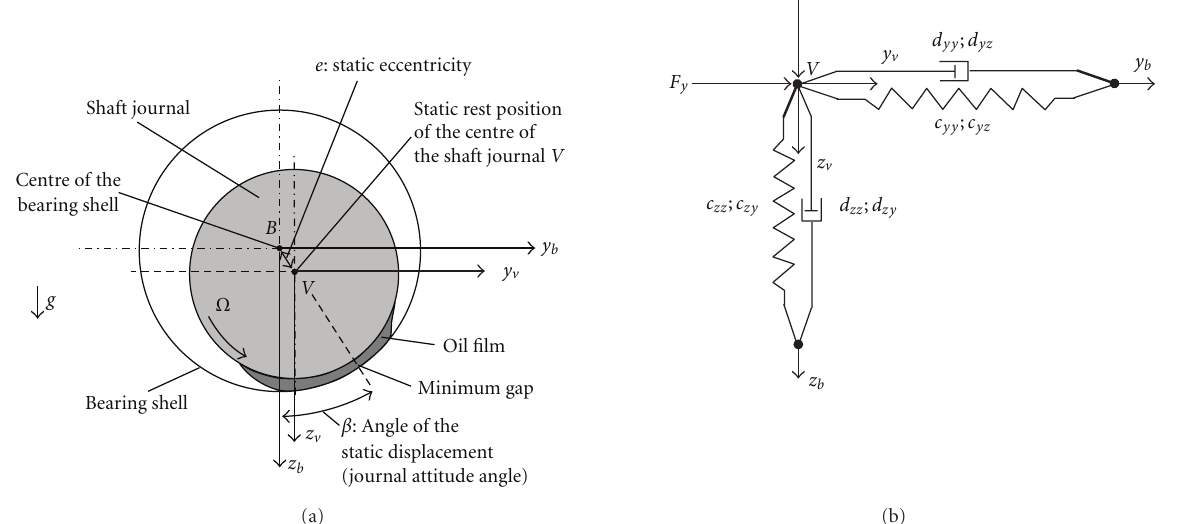
Figure 2: (a) Static rest position of the shaft journal point V in a hydrodynamic sleeve bearing. (b) Additional forces F z and F y at the static rest position causing relative displacements between the centre of the bearing shell B and the shaft journal V .